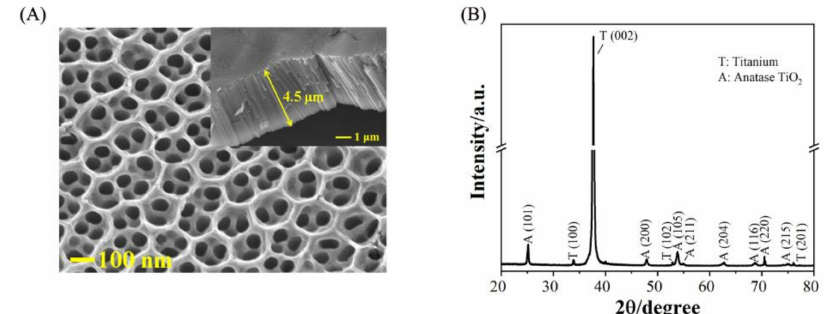
Figure 1. ( A ) Top-view and side-view SEM images of the TiO 2 nanotube array (TNA) and; ( B ) XRD pattern of the TNA calcined at 450 ◦ C.